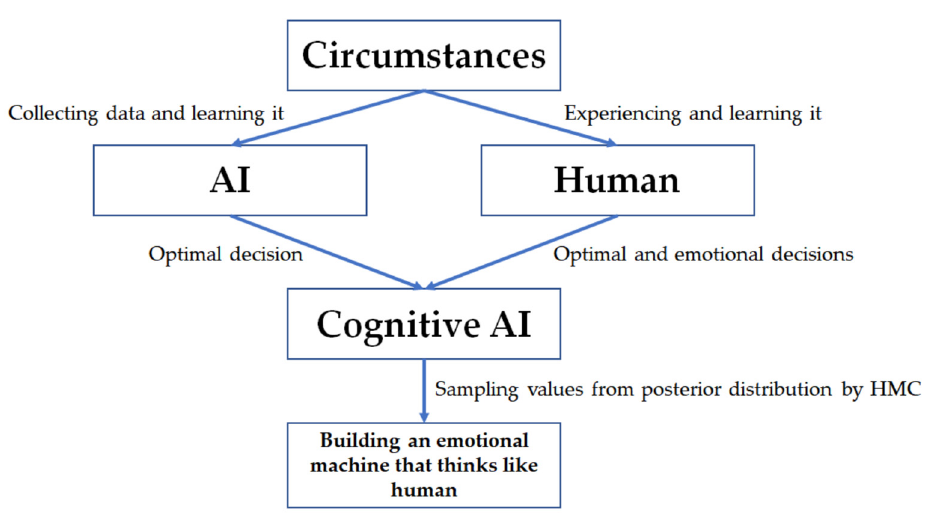
Figure 3. The flowchart for the proposed method. In Figure 3, AI and humans all collect experience and data from external